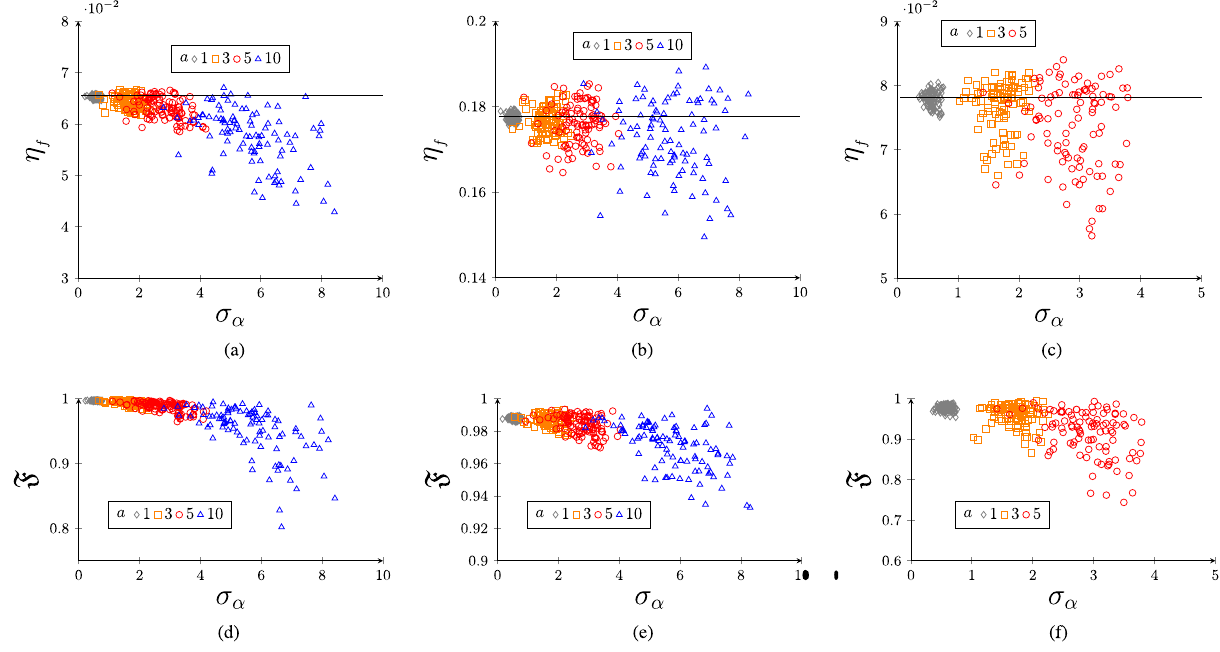
3 , α L 6 , α L 18 ), ( b ) ( F 30 ) and ( c ) (Cesium at 0.1T) we plot = = = =